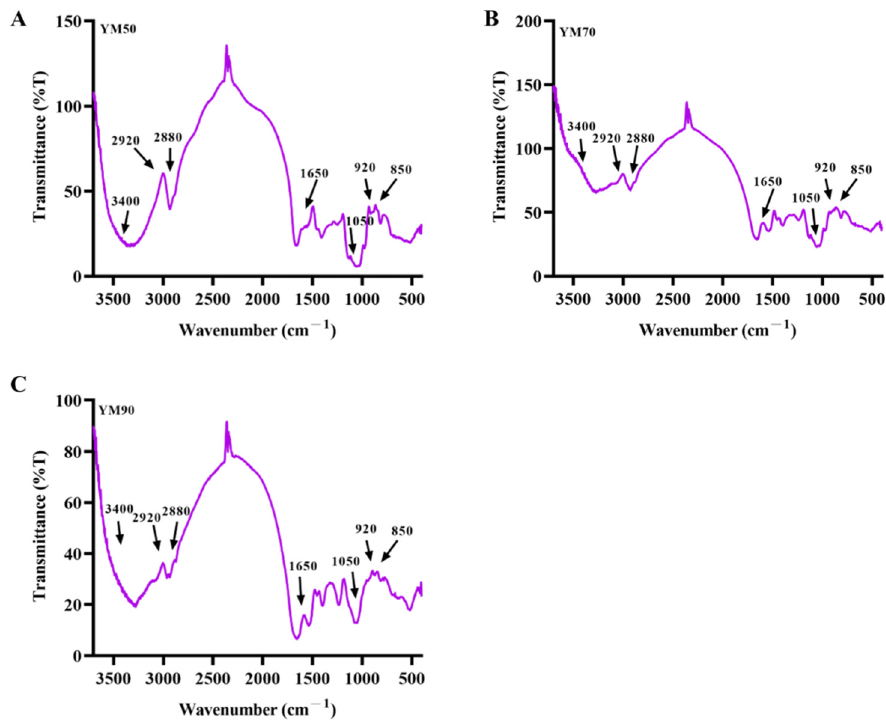
Figure 3. FTIR spectra of mannans (( A – C ) stands for YM50, YM70, and YM90, respectively).